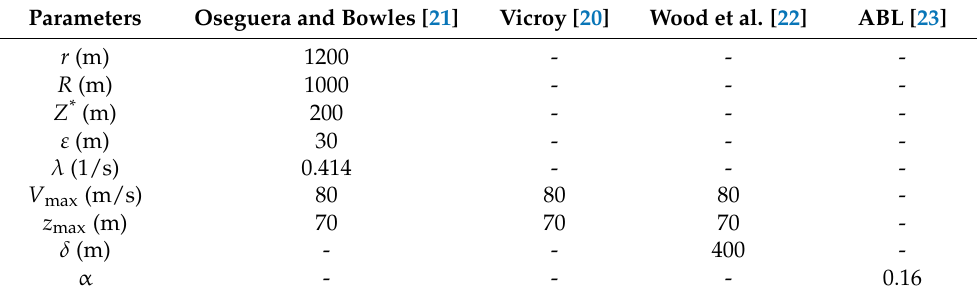
Table 1. Parameters for the profile models in Figure 1.